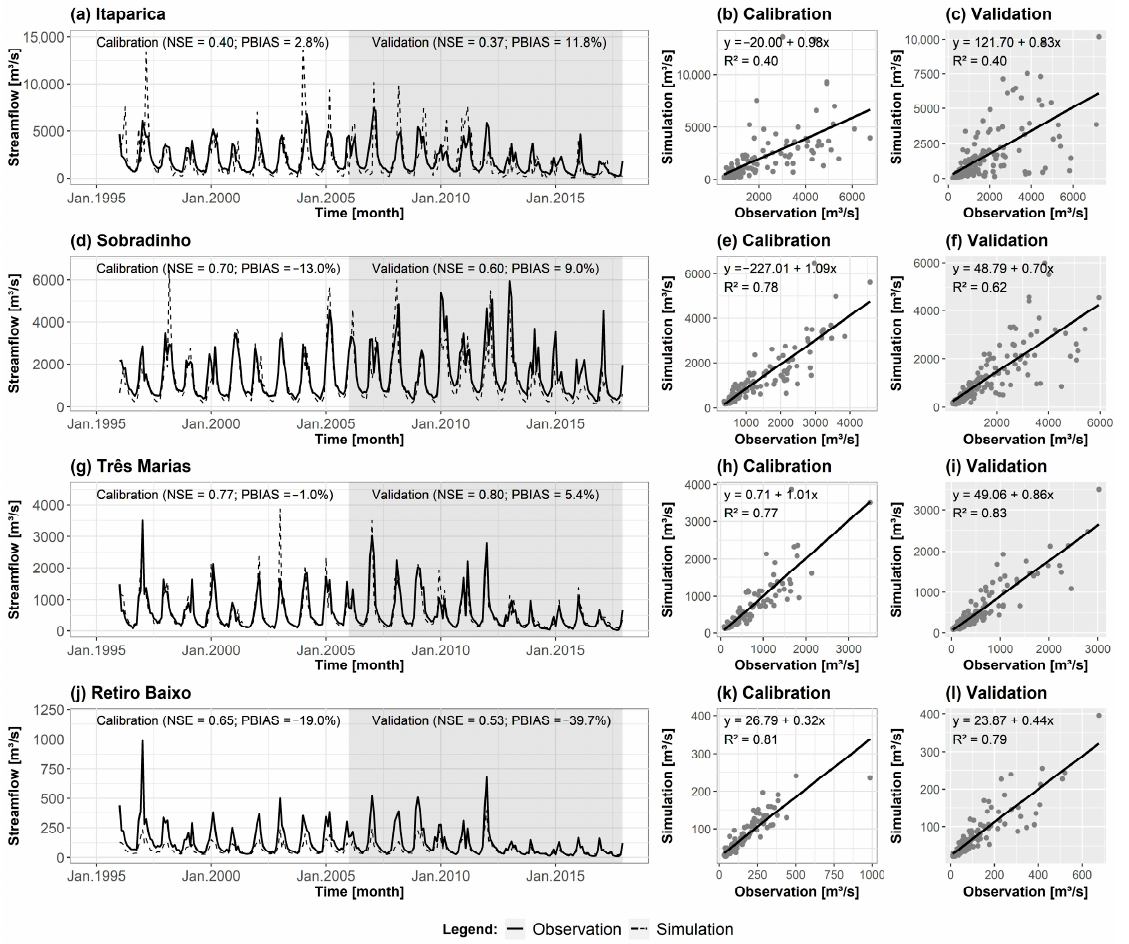
Figure 4. Simulated Flow—Calibration (1996 to 2005) and Validation (2006 to 2017) results. Ac- cording to [35], a hydrological model is considered “very good” if 0.75 < NSE < 1.00 and PBIAS < ±10; “good” if 0.60 < NSE ≤ 0.75 and ± 10 < PBIAS ≤ ±15; “satisfactory” if 0.36 < NSE ≤ 0.60 and ± 15 < PBIAS ≤ ±25.